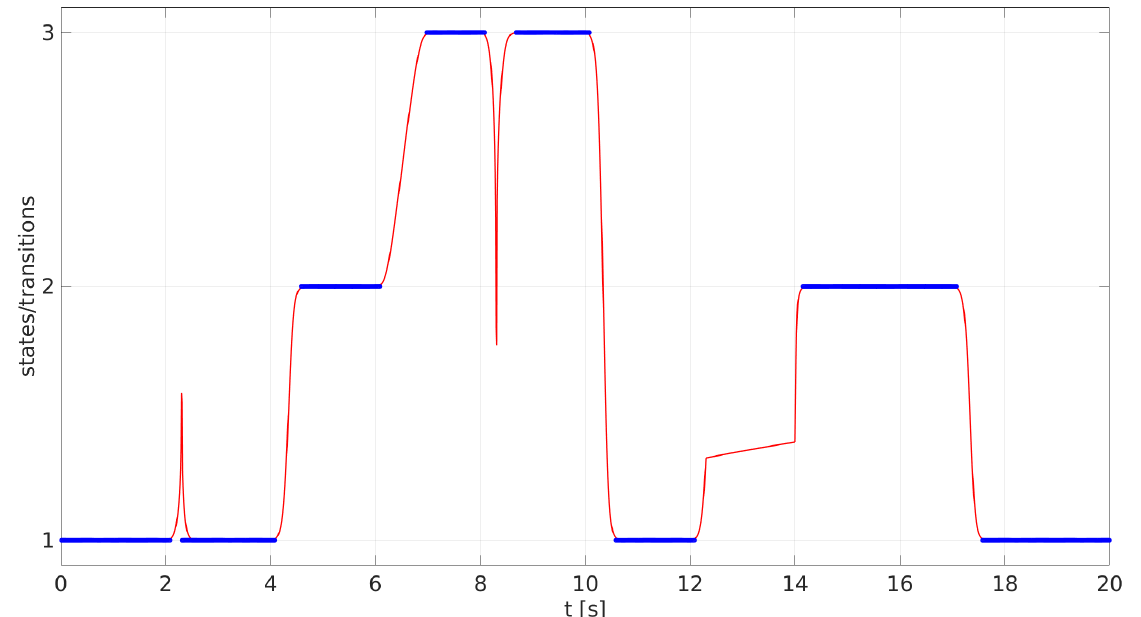
Figure 3. The time evolution of the three-state SHC system. The blue lines represent the system states, while the red lines represent the transitions from the initial to the final states and were obtained from the evolution phases from Equation